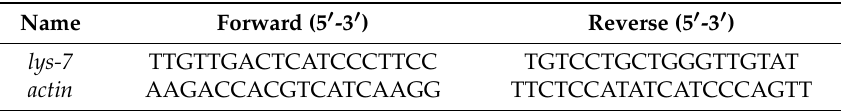
Table 2. Primers for real-time Polymerase Chain Reaction (PCR) used in this